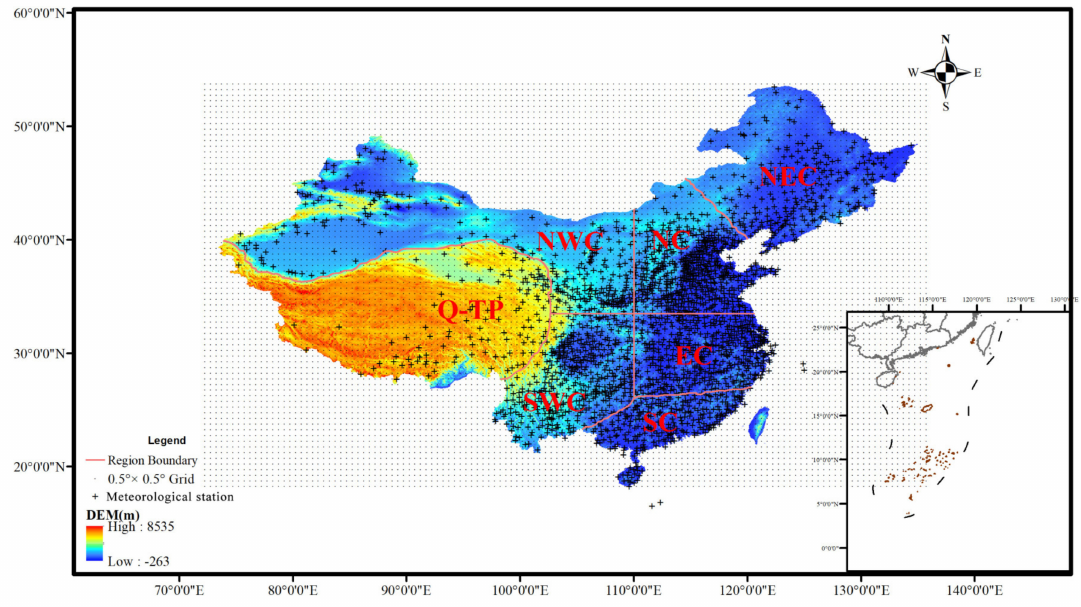
Figure 1. Digital elevation model of China and its distribution of seven